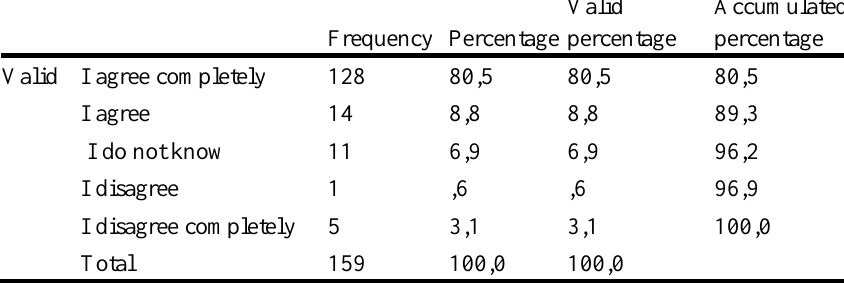
Valid percentage questionnaires´ results, question 16 “Students appreciate the role of the teaching assistant in the